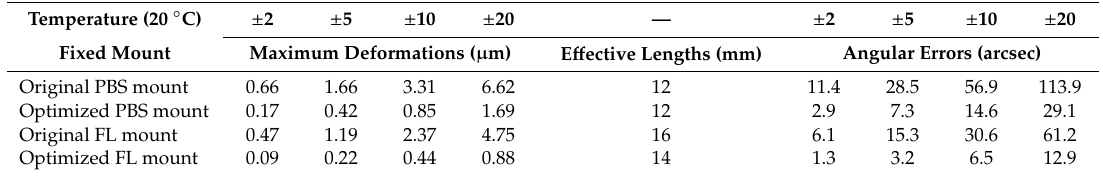
Table 2. The angular errors around the Y axis of the fixed mounts.